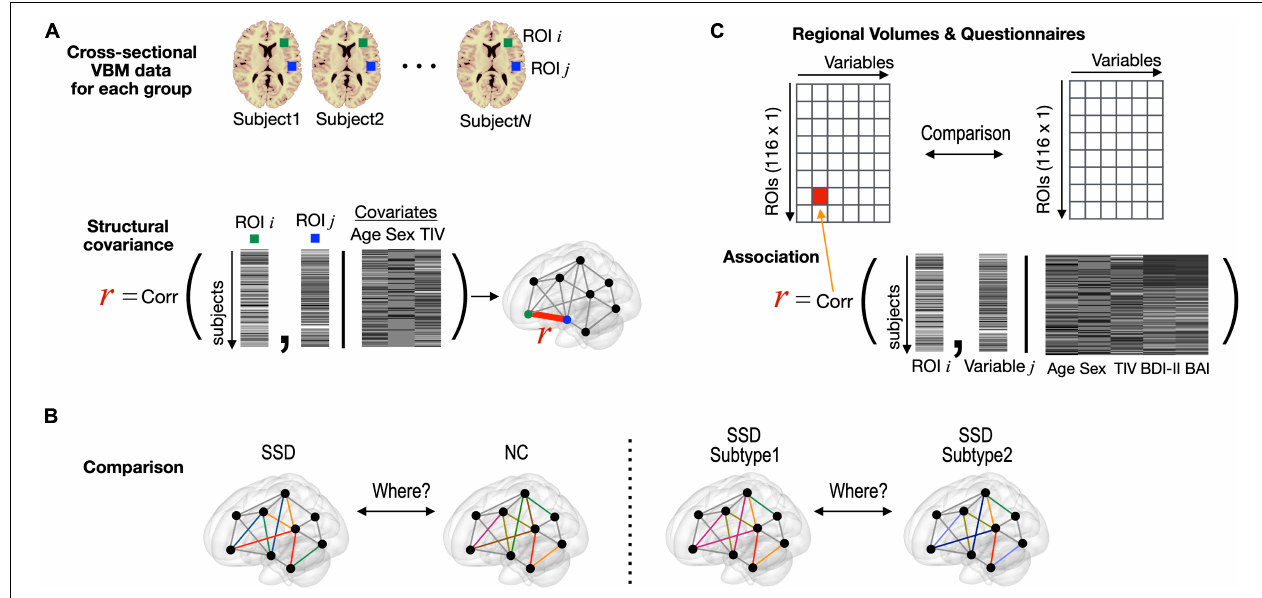
FIGURE 2 | Statistical procedures used in this study. (A) Structural covariance between two regions was defined as partial correlation between two regional volumes (covariates: age, sex, and TIV), which were obtained from cross-sectional VBM data for each group. (B) Structural covariance was compared edge-by-edge between the entire SSD and normal control groups and between the subtype 1 and subtype 2 groups within SSD. (C) Partial correlation analysis with rGMV data and clinical variable. TIV, total intra-cranial volume; VBM, voxel-based morphometry; SSD, somatic symptom disorder; NC, normal control; ROI, region of interest; BDI-II, Beck Depression Inventory-II; BAI, Beck Anxiety